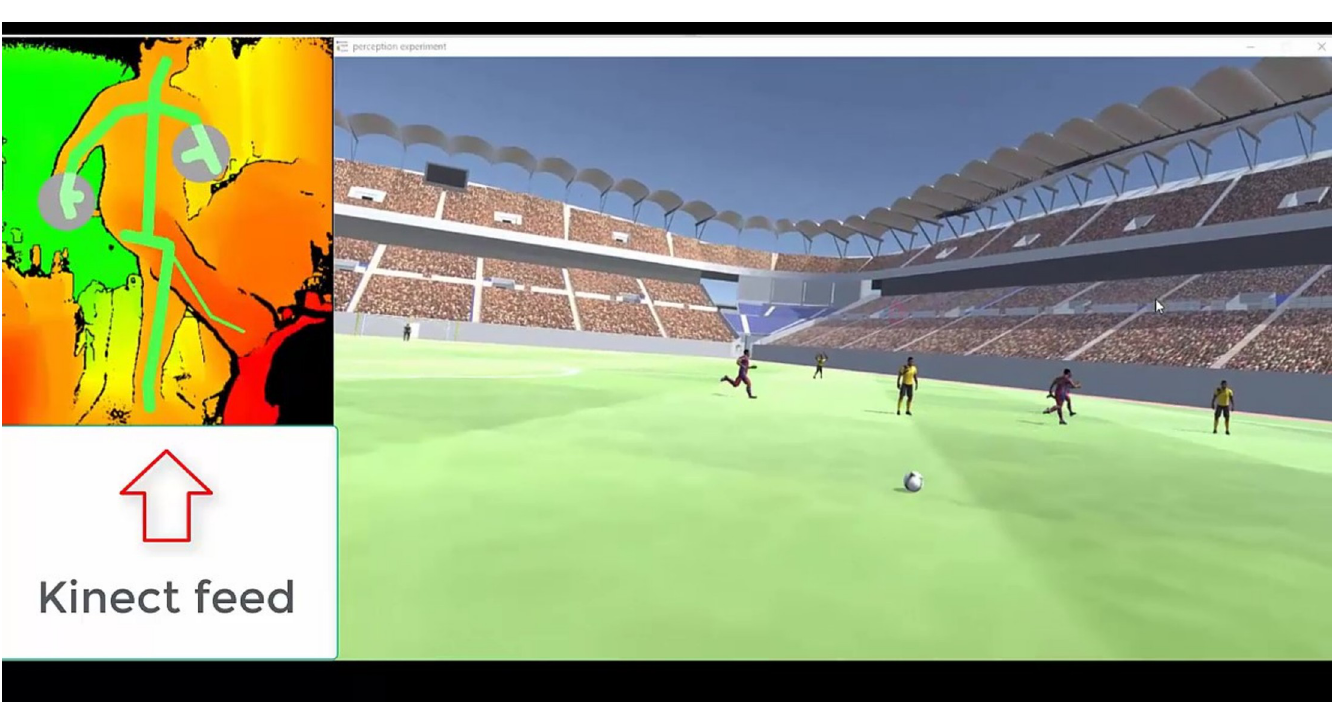
Fig 4. Kinect feed of the user inside the simulation. The left shows the image detected by the sensor of a user performing the passing gesture, while the right is the resulting ball pass inside